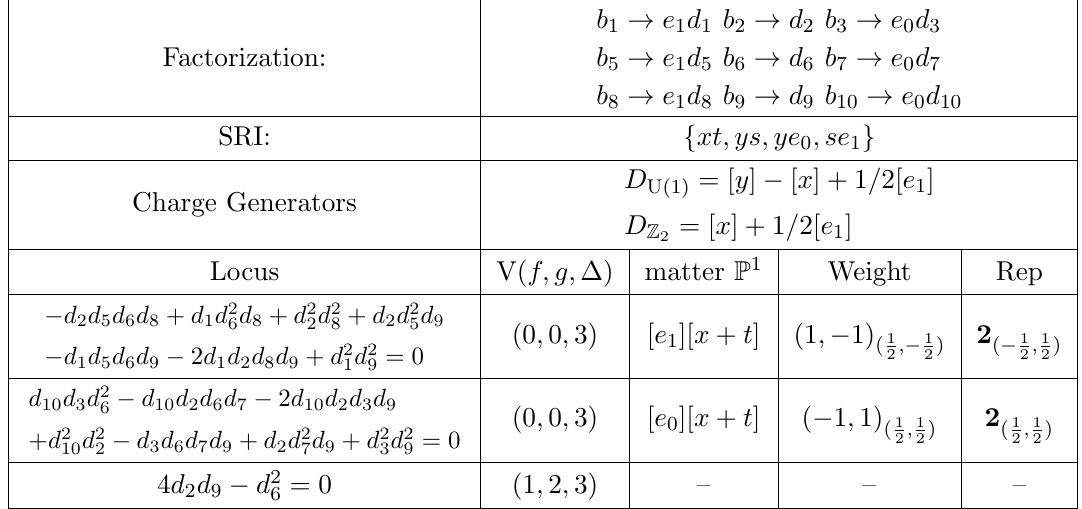
Table 13 . Summary of SU(2) top 3. In this model the discrete symmetry is enhanced to Z 2 due to the form of D Z . Hence, the representations are labeled by Z 4 charges, which here are 2 multiples of 1 modulo 2 Z . Note that the charge assignments exhibit the global gauge group structure 2 [SU(2) (cid:2) U(1) (cid:2) Z 4 ] = ( Z U(1) 2